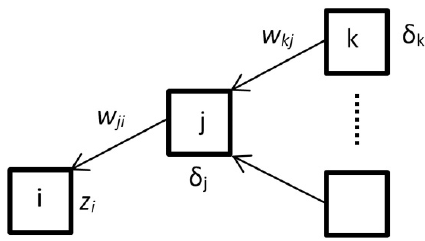
Figure 5. Model of backward error propagation.